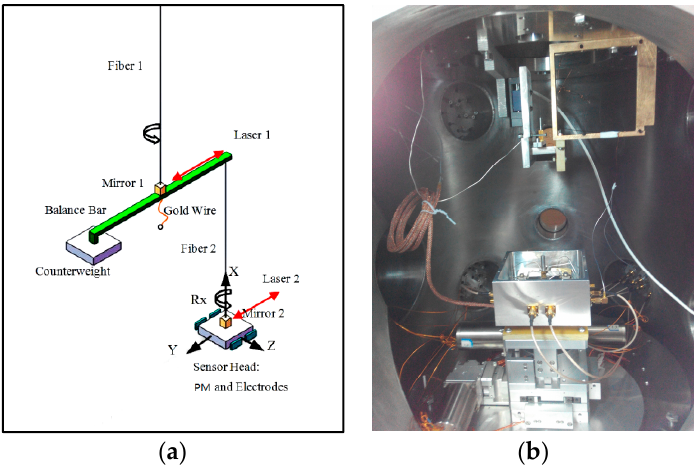
Figure 11. ( a ) Schematic of two-stage electrostatically-controlled torsion pendulum; ( b ) experimental setup of two-stage torsion pendulum in vacuum chamber.